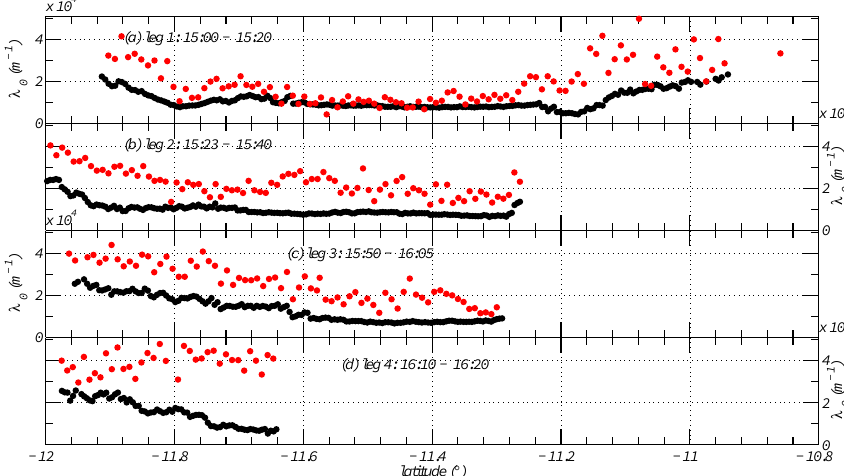
Fig. 6. The derived λ 0 (m − 1 ) for each leg using both the CIP (black) and the CPI (red) as a function of latitude with each flight leg as a function of increasing distance from the storm (a)-(d). In general λ 0 stays approximately constant, on average, with distance from the storm. Note that differences in λ 0 between the two probes arise because of their different size-ranges (see Fig. 5 and text for discussion).